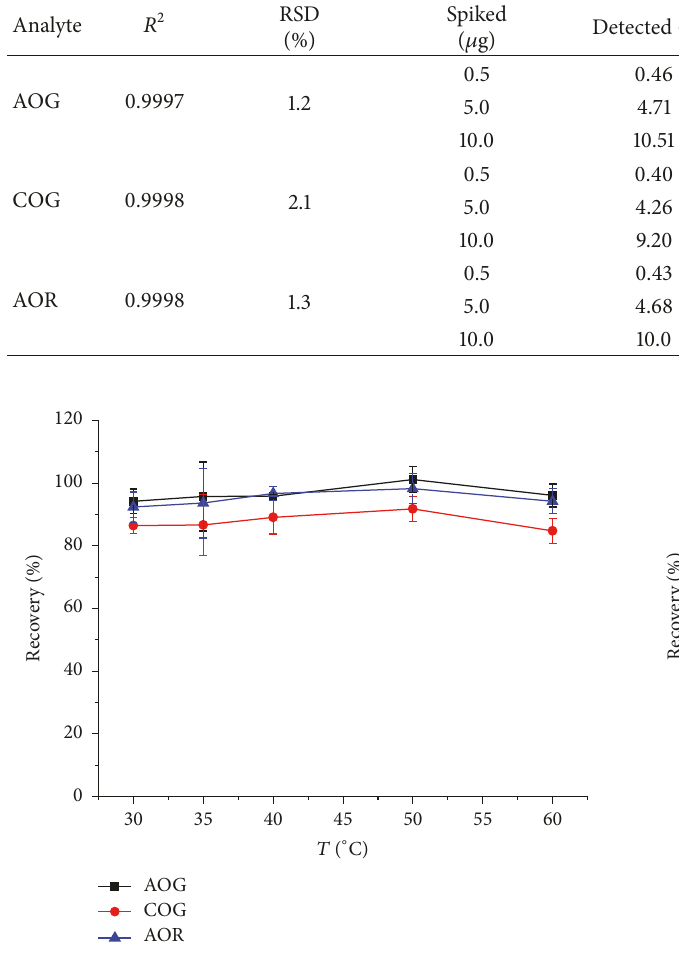
Figure 5: Effect of temperature on the recoveries of dyes. Sample/DES-1-2: 0.1g/mL, time: 20 min, and ultrasonic power: 75 W.